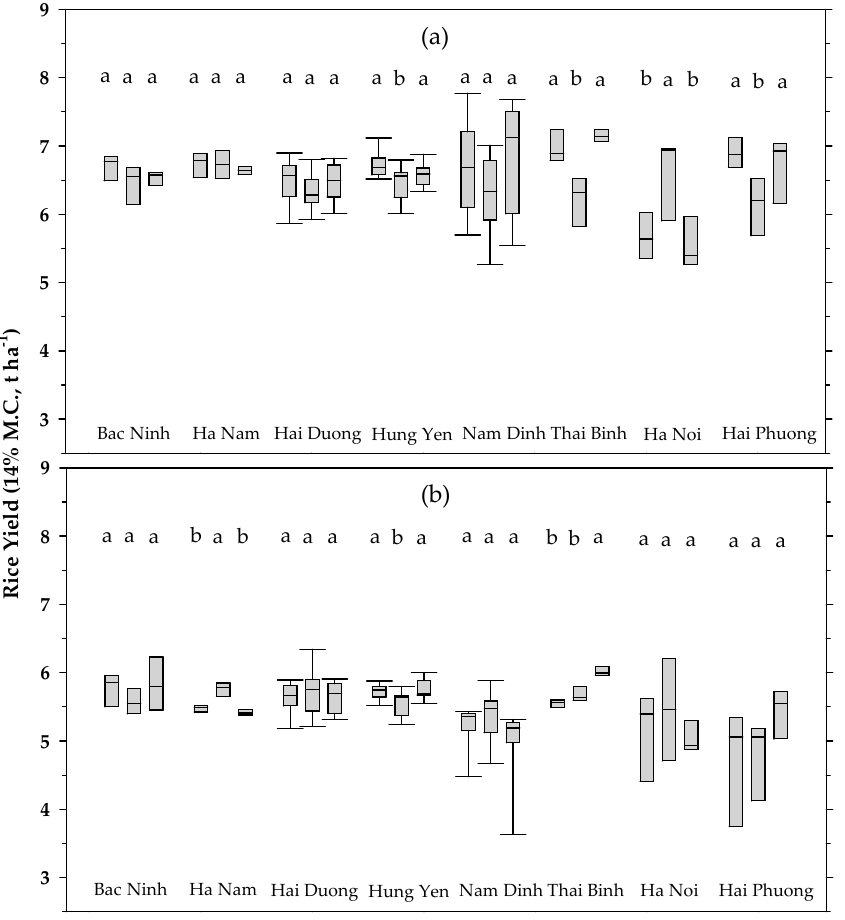
Figure 5. Box plots of rice yield aggregated at the district level summarized for eight provinces in the Red River Delta of Vietnam (study sites) for the 2016: spring ( a ); and summer ( b ) seasons. In each province, the three box plots represent yield data derived from MODIS, Sentinel-1, and an official source, sequentially, with the corresponding group of three letters near the top of the graphs representing analysis of variance least significant difference, ANOVA LSD, assignment comparing the three datasets.